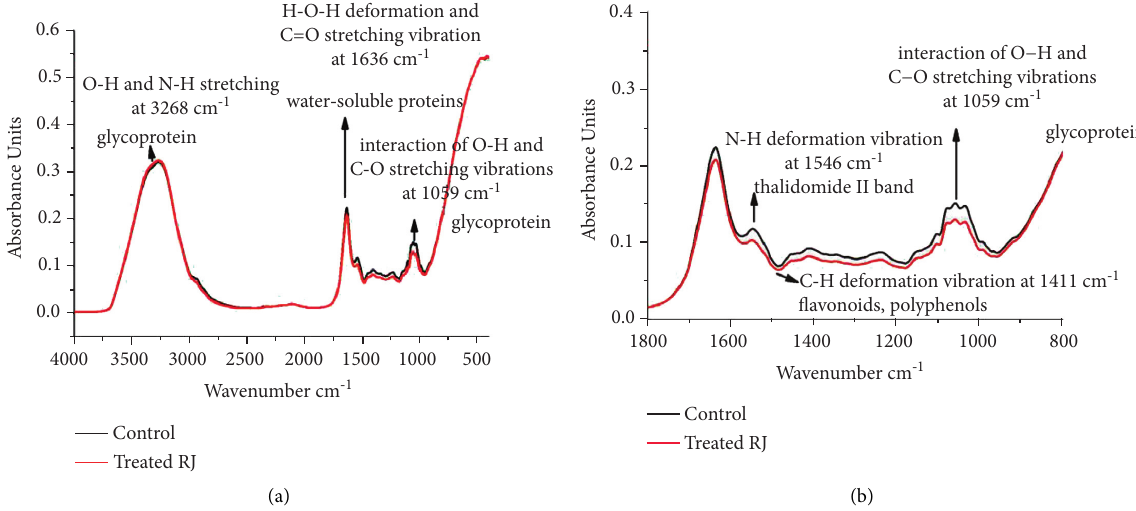
Figure 5: (a) Effects of ambient temperature (28 ° C) on the characteristic of the average middle infrared spectrum of the RJ samples (4000–500 cm − 1 ); (b) effects of ambient temperature (28 ° C) on the characteristic of average middle infrared spectrum located in the fingerprint region (1800–800cm − 1 ).